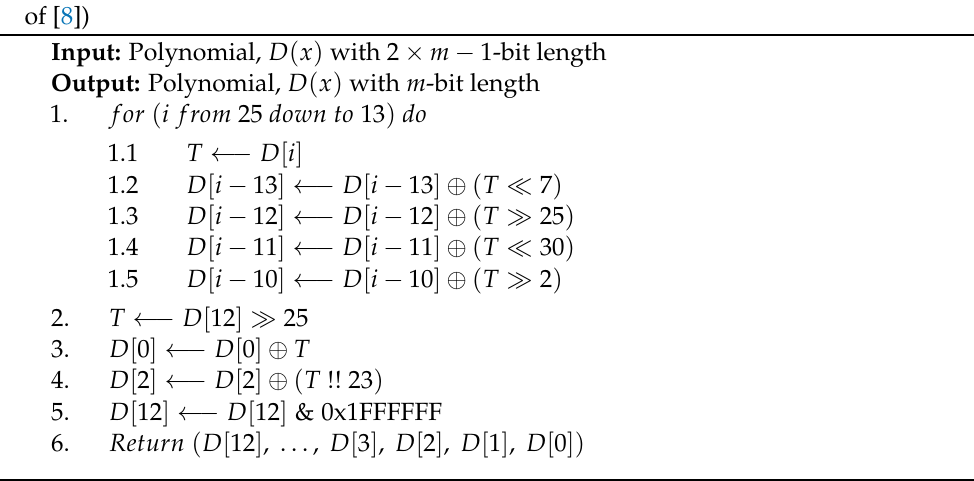
Algorithm A4: Polynomial Reduction Algorithm over GF ( 2 409 ) (algorithm 2.44